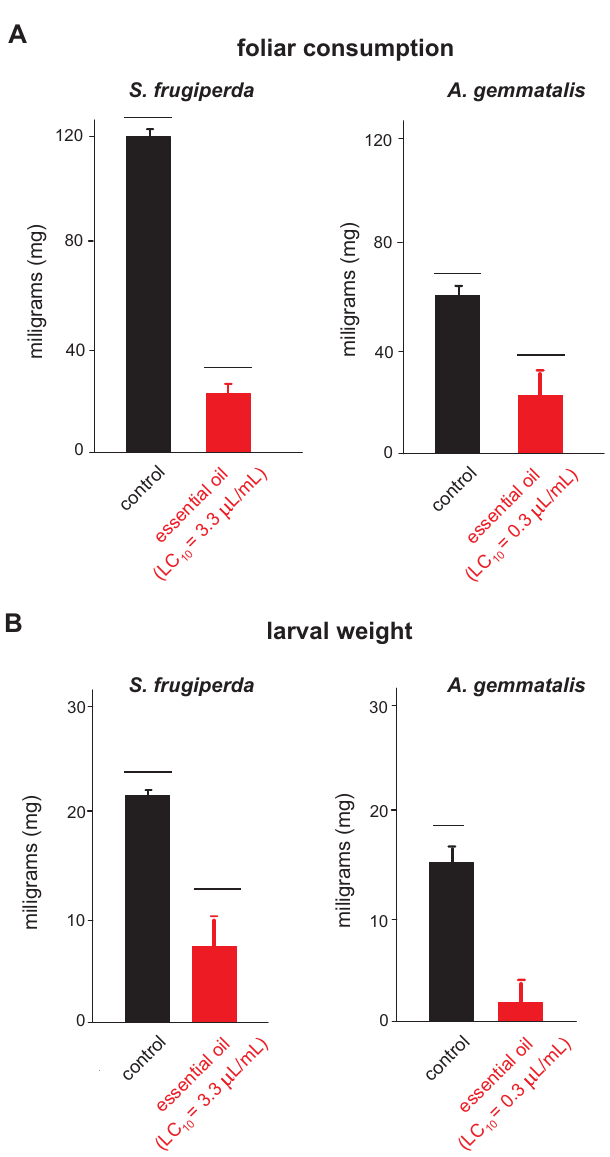
Figure 6. Foliar consumption (mg) and weight gain of the 3 rd instar larvae of Spodoptera frugiperda and Anticarsia gemmatalis feeding on maize or soybean leaves in no choice experimental design. Horizontal bars indicate significant differences ( P < 0.05) between sprayed with sublethal dose (LC 10 ) and unsprayed leaves maize and soybean.